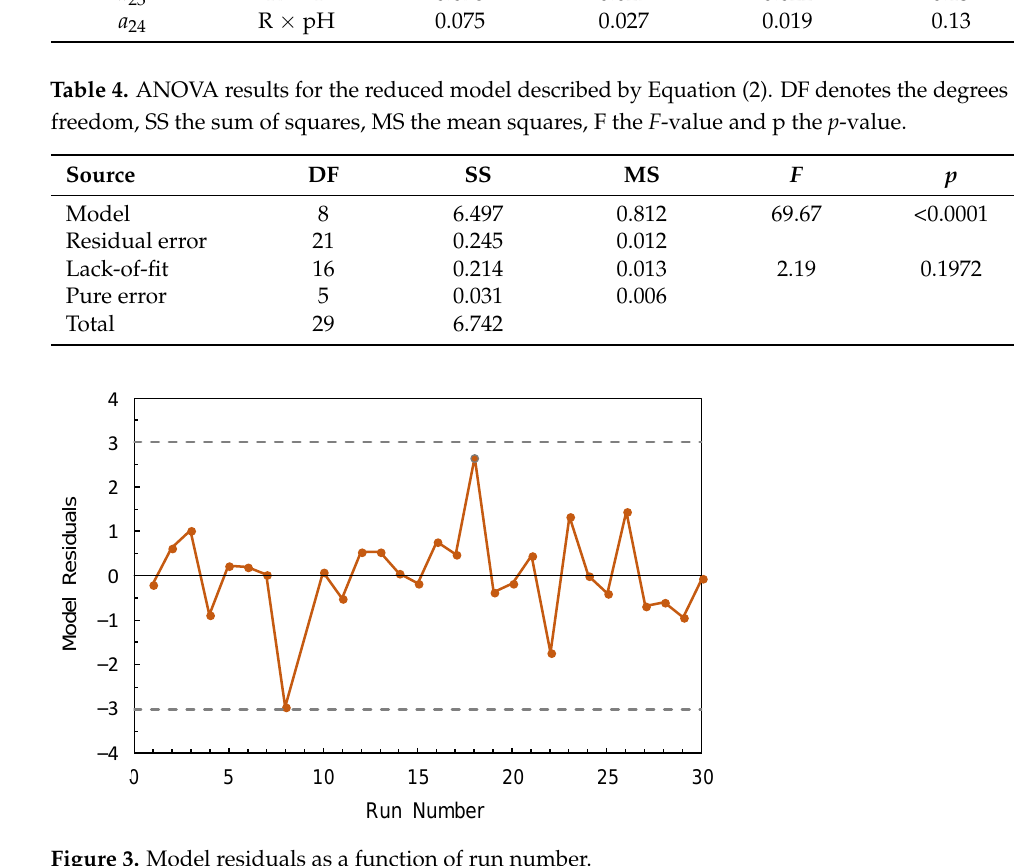
Figure 3. Model residuals as a function of run number.